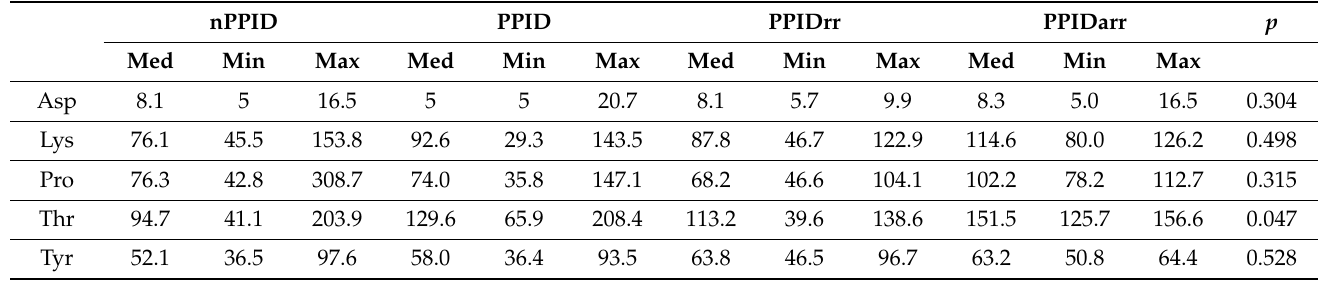
Table 3. Median, minimum, and maximum of the non—normally distributed amino acid concentra- tions (nmol/mL); Kruskal—Wallis